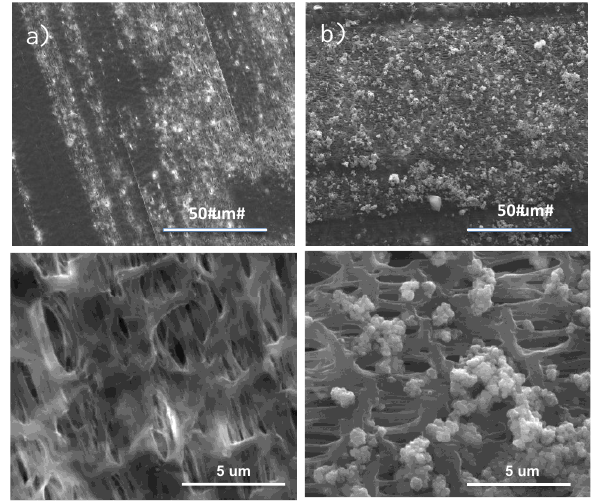
Figure 1. SEM micrographs collected onto the shell side of polyethylene (PE) hollow fiber membranes before ( a ) and after ( b ) (PAA/TiO 2 ) 15 (PDDA) 15 layer-by-layer (LBL) deposition.